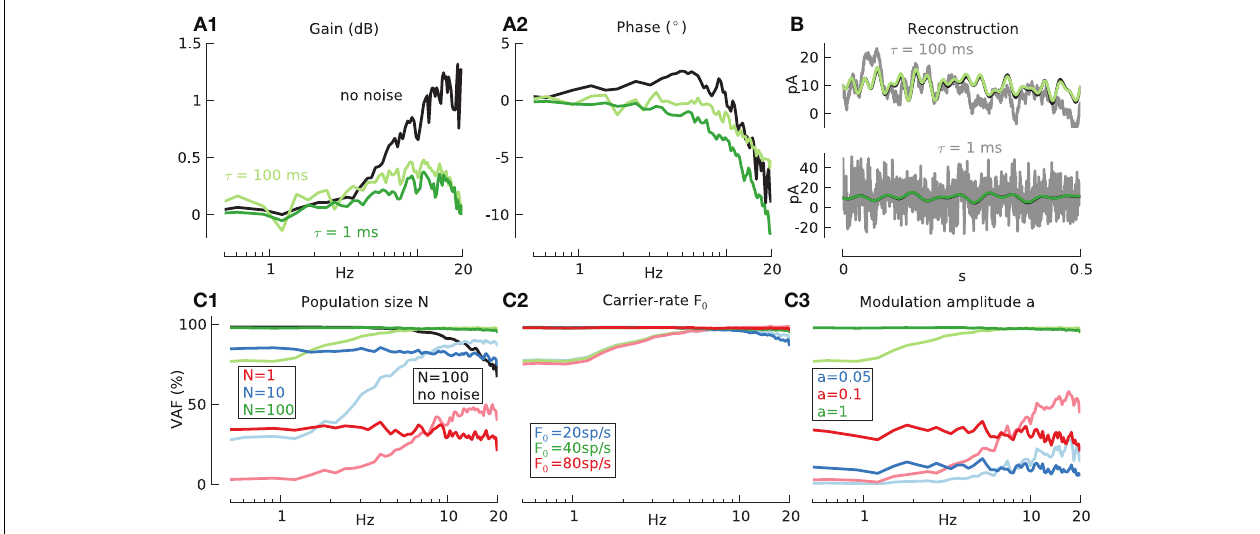
FIGURE 4 | Information transmission by model GrC in response to modulated current injection, with additive noise. Baseline condition for all following simulations: population size N = 100, mean carrier-rate m ( F 0 ) ≈ 40 spikes / s, std ( F 0 ) ≈ 0 spikes / s and modulation amplitude a = 1. (A) Effects of noise on transfer function of GrC model (A1 gain, A2 phase) measured using the sampling-rate filter method, with 20Hz low-pass filtered white noise as the input signal (black lines) and fast ( τ n = 1 ms , a n = 4, dark green lines) or slow ( τ n = 100 ms , a n = 2, light green lines) additive correlated white noise. (B) Reconstruction, from stimulation with additive fast (green line) or slow (light green line) noise, of input signal (black line) from GrC response. Total input current to one exemplary cell shown in gray. (C) Reconstruction quality (VAF) for GrC model under varying conditions. (C1) Effects of population size N and fast noise ( N = 1: red, N = 10: blue, and